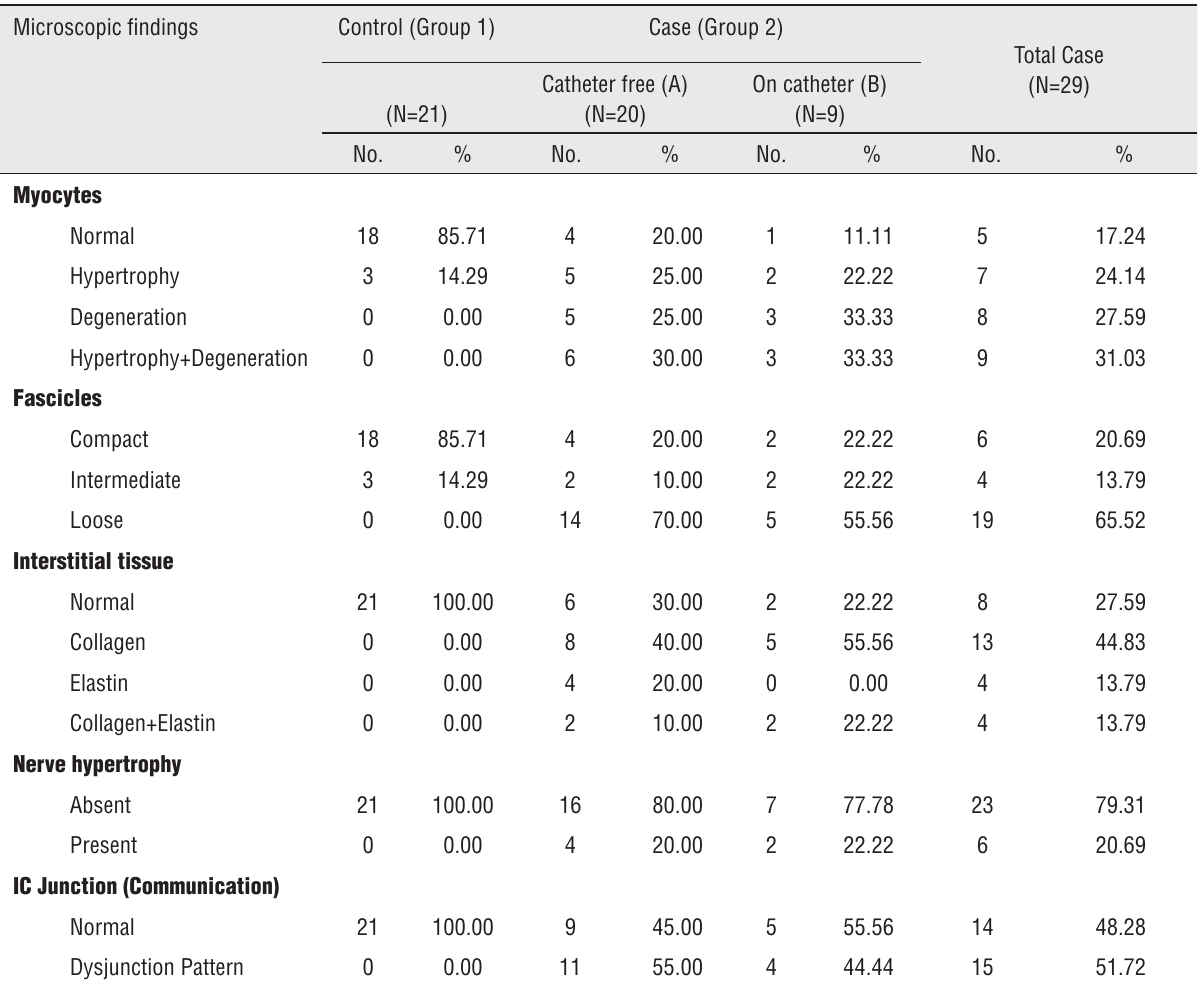
Table 2 - Comparison of electron microscopic findings between groups and statistical correlations. Microscopic